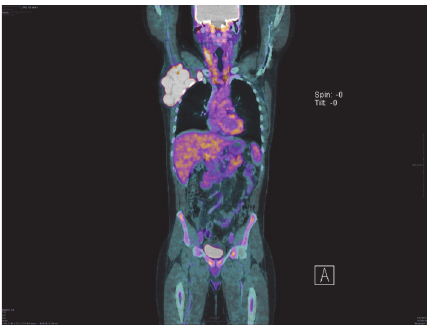
Figure 1: PET CT before treatment. Stage II bulky Hodgkin lym- phoma.